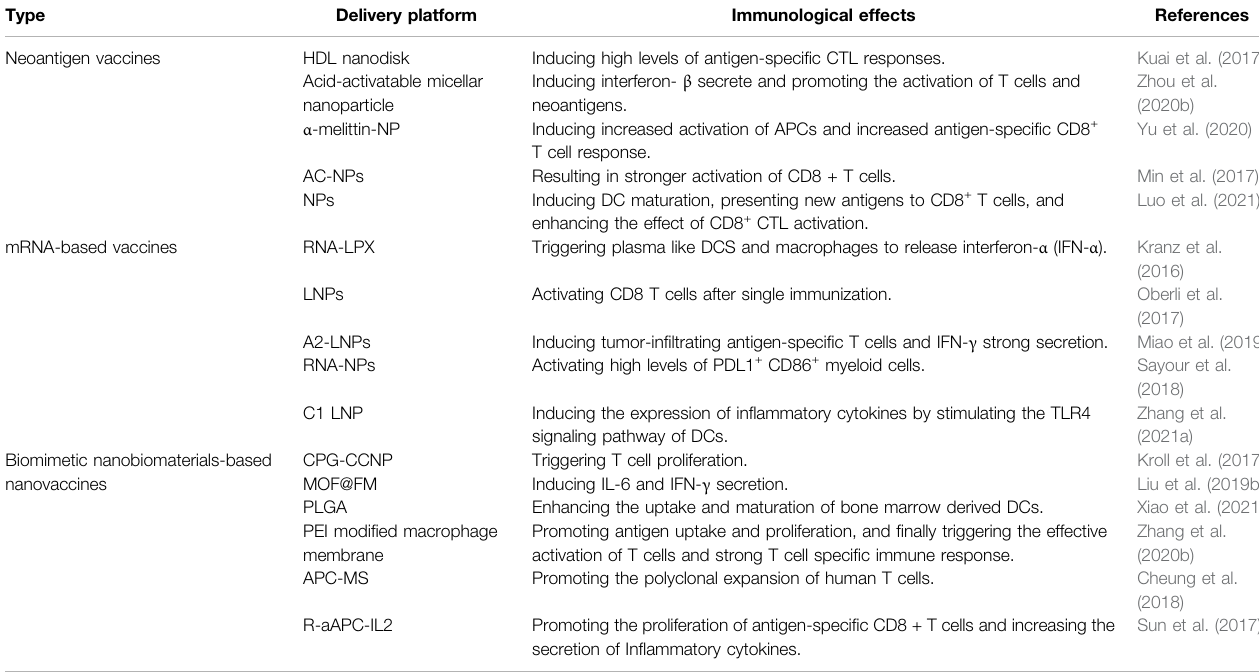
TABLE 1 | Nanovaccines for cancer